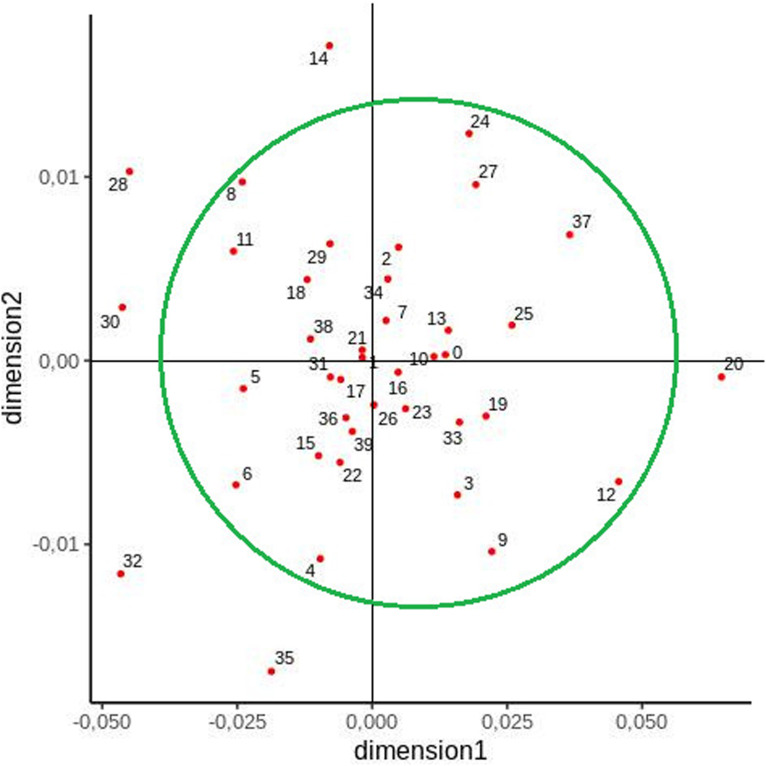
Two-dimensional MDS plot of cluster populations based on pairwise FST values.